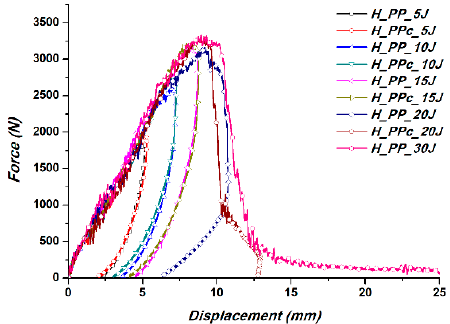
Figure 10. Typical force–displacement curves of flax/basalt hybrid thermoplastic composites in the whole range of impact energies.